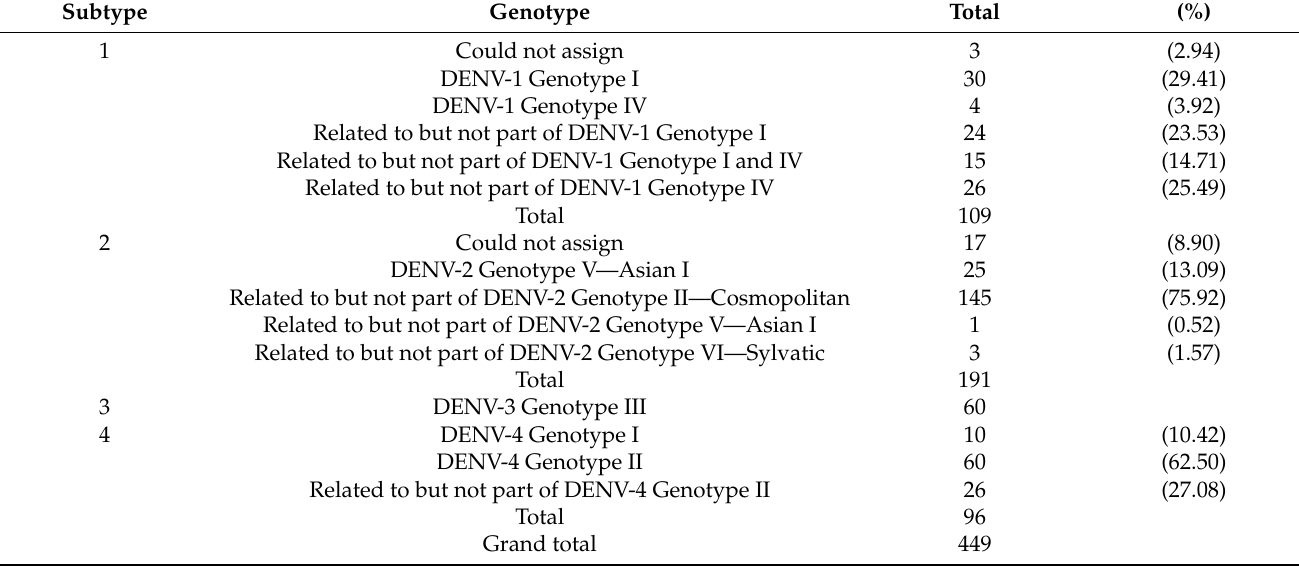
Table 4. Prevalence and distribution of dengue genotypes reported in the present study.